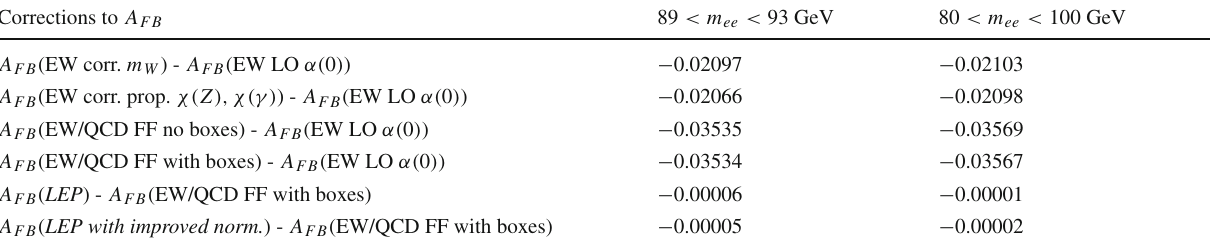
Table 5 The difference (cid:8) A FB in forward-backward asymmetry calculated in the specified mass window. The cos θ CS is used to define forward and backward hemispheres. The EW weight is calculated from θ ∗ definition of the scattering angle Corrections to A FB 89 < m ee < 93 GeV